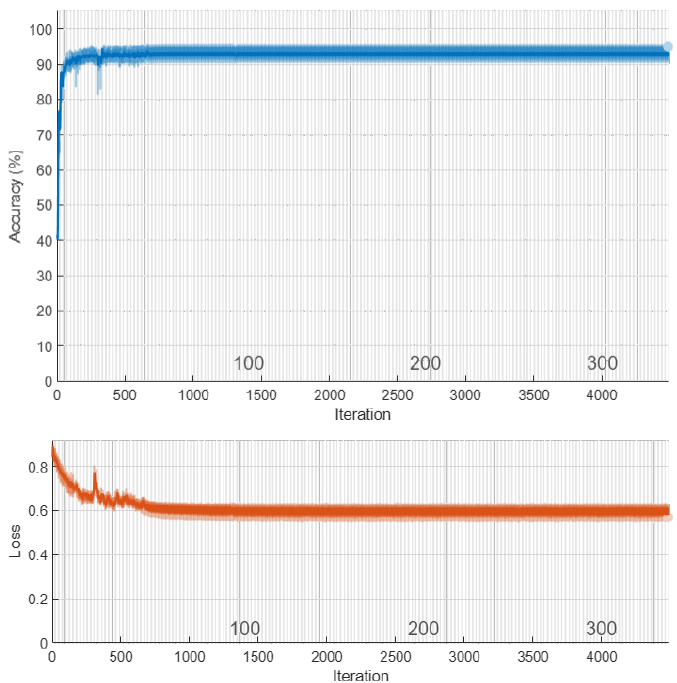
Figure 9. The accuracy and loss of CNN network for cancer tumor segmentation.